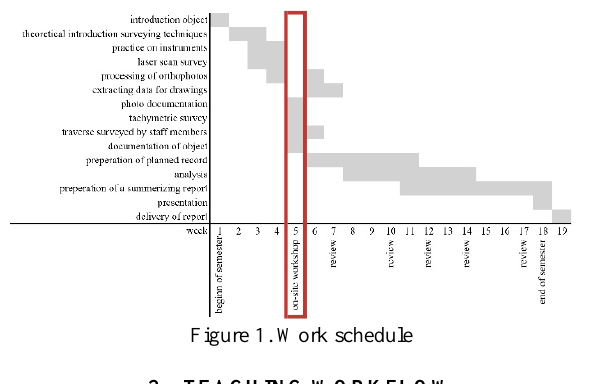
Figure 1. Work schedule